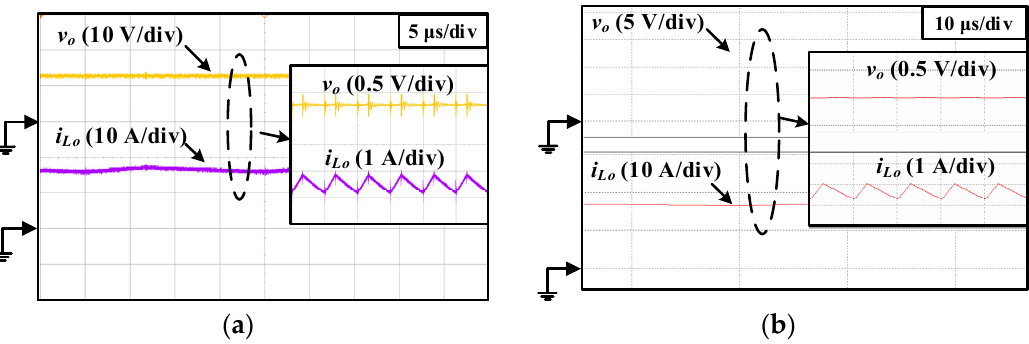
Figure 17. The waveforms of v o and i Lo with zoomed-in observation: ( a ) practical measurements, and ( b ) simulated results.